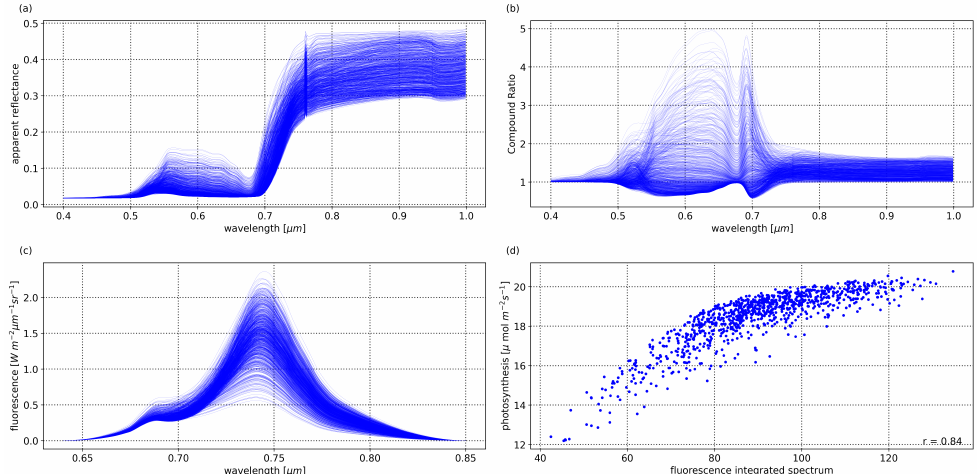
Figure 6. SCOPE model simulations with varying chlorophyll AB content ( C ab ), carotenoid content ( C ca ), dry matter content ( C dm ), leaf water equivalent layer ( C w ), and senescent material fraction ( C s ), showing ( a ) the apparent reflectance spectrum ( R ∗ ), ( b ) the Compound Ratio ( C V using Equation (8), ( c ) the fluorescence emitted per wavelength in observation direction, and ( d ) photosynthesis as a function of the area under the fluorescence